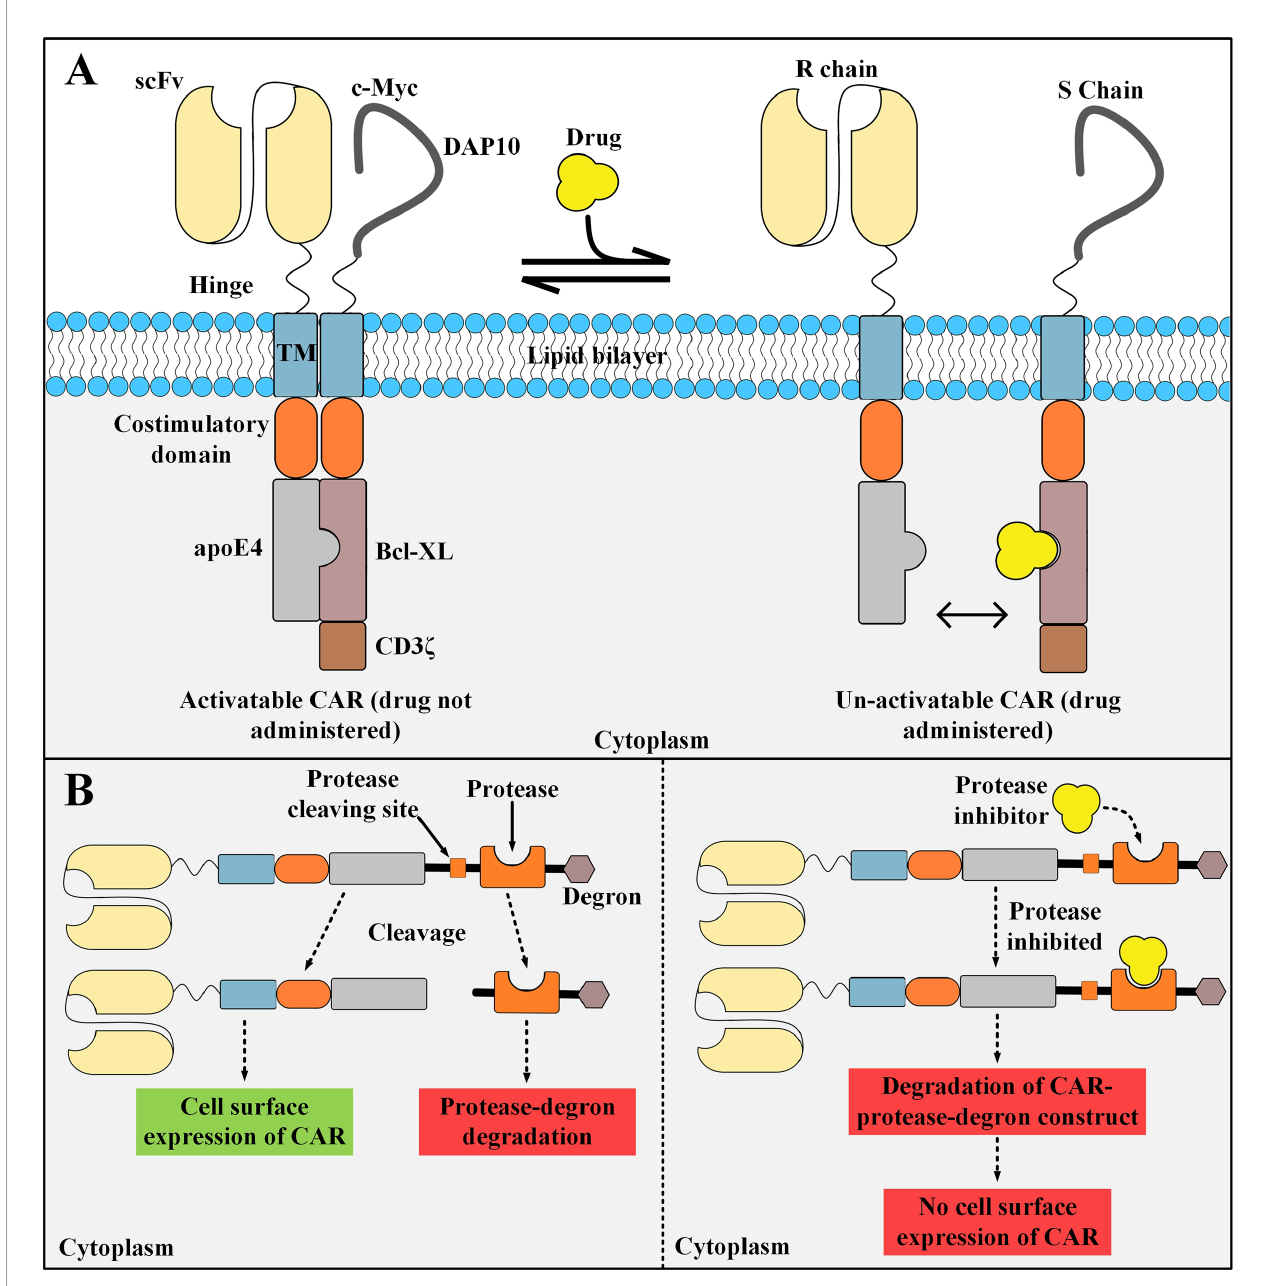
FIGURE 5 | STOP CAR and SWIFF-CARs structures and action mechanisms. (A) The STOP-CAR platform. The S chain is made of a c-myc and DAP10 (which are used for enhancing the stability and expression of the S chain), a hinge, a transmembrane domain, a co-stimulatory domain, Bcl-XL, and CD3 z . On the other hand, the R chain is made of an scFv, a hinge, a transmembrane domain, a co-stimulatory domain, and human apolipoprotein E4. When the disruptive drug is not administered, the R and S chain can bind to each other and the CAR can be activated upon target antigen engagement. After the disruptive drug administration, it binds to its binding site on the Bcl-XL domain located on the S chain, therefore, it renders the R and S chain unable to pair and the CAR un-activatable. (B) A simpli fi ed illustration of the SWIFF-CAR platform. In the absence of the protease inhibitor (left panel), the protease retains its proteolytic activity and binds to its cleaving site leading to the dissociation of the CAR molecule from the rest of the construct and its translocation to the cell surface resulting in normal CAR-mediated antitumor activity. In the presence of the protease inhibitor (right panel), the inhibitor binds to its binding site located on the protease and mediates its inhibition, therefore, the protease cannot bind to its cleaving site which results in the degradation of the CAR molecule and the rest of the construct in the T cell proteolytic pathways (right panel). apoE4, human apolipoprotein E4; scFv, single-chain variable fragment; CAR, chimeric antigen receptor. R chain, recognition chain; S chain, signaling